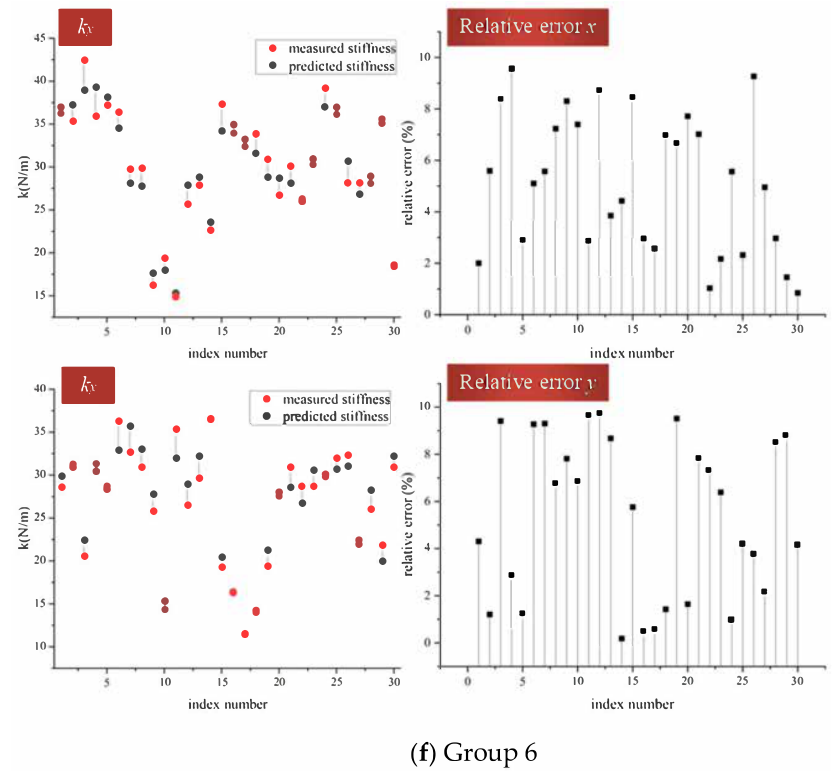
Figure 4. The comparison of tangential contact stiffness between measured ones and predicted ones among different